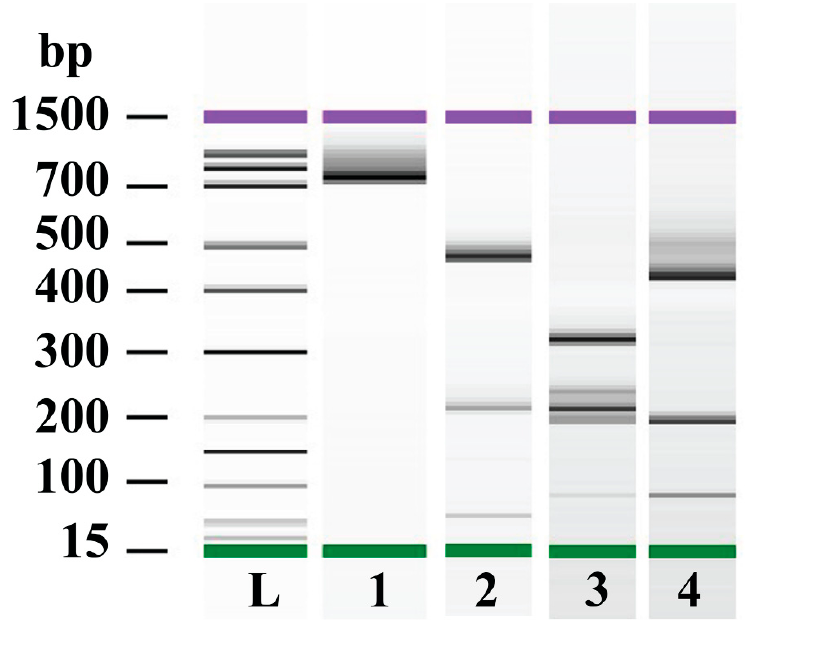
Figure 2. Electrophoresis representation of the Agilent Bioanalyzer 2100 gel-electropherograms of PCR products generated by primers flanking the internal transcribed spacer (ITS) region of ITS-1 and ITS-4 and PCR–restriction fragment length polymorphism (RFLP) products from G. simplicifolia . Lane 1, PCR product of the spacer region produced a band of about 758 bp; Lane 2, PCR–RFLP analysis using MspI G. simplicifolia digested PCR products gave three bands of about 471, 312, and 57 bp; Lane 3, PCR–RFLP analysis using HhaI G. simplicifolia digested PCR products produced five bands of about 319, 240, 215, 198, and 86 bp; Lane 4, PCR–RFLP analysis using HaeIII G. simplicifolia digested PCR products generated three bands of about 431, 198, and 86 bp. L = bp markers. The green bar indicates the lower marker (15 bp), whereas the violet band indicates the upper marker (1500 bp). See Supplementary data of G. simplicifolia